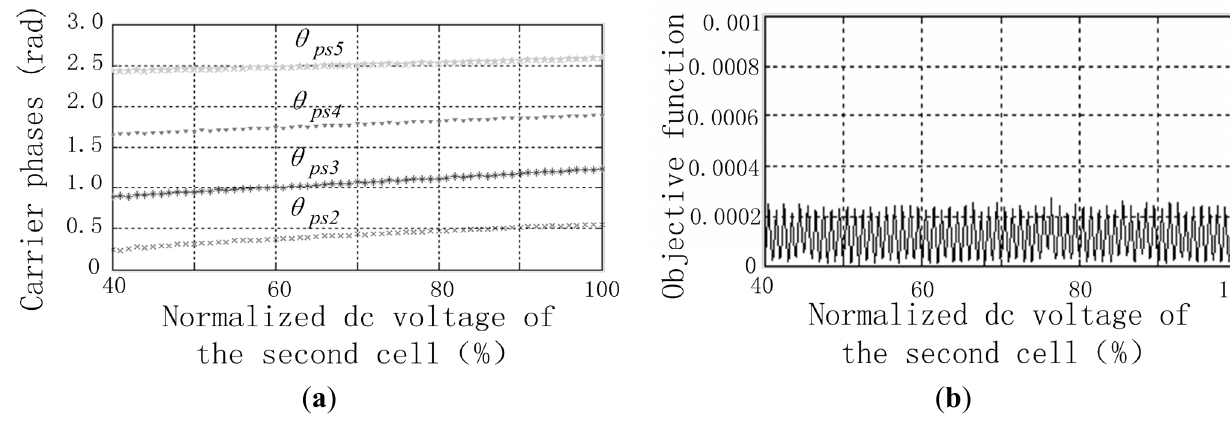
Figure 3. ( a ) Four calculated carrier phases; and ( b ) values of the objective